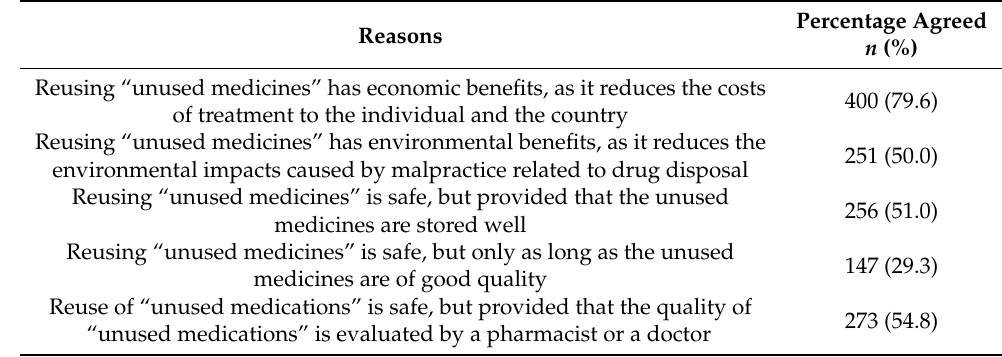
Table 4. Perceptions toward reusing medicines among those participants who are willing to reuse medications ( n = 502).